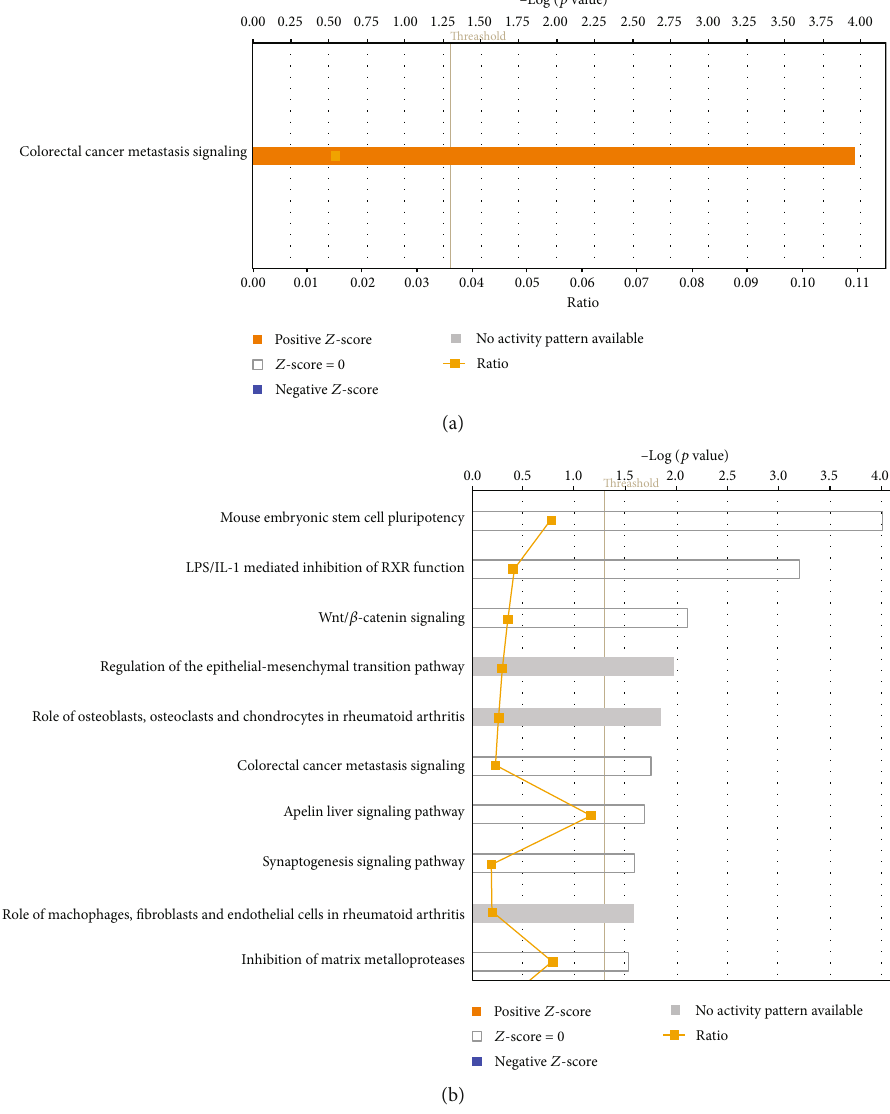
Figure 2: (a) Low-intensity ultrasound (LIUS) upregulates 21 out of 1376 (1.5%) innatomic genes and downregulates 17 out of 1376 (1.2%) innatomic genes in mouse preosteoblast cells (GSE45487), suggesting that LIUS increases innatomic gene expressions slightly more than decreasing them in mouse preosteoblast cells (see supplemental Table 2 for the detailed gene list). LIUS upregulated 21 innatomic genes that were signi fi cantly involved in one signaling pathway in mouse preosteoblasts, which is in fl ammation-driven cancer metastasis signaling. (b) LIUS downregulated 17 innatomic genes that were not signi fi cantly involved in any signaling pathway in mouse preosteoblast cells, suggesting that LIUS inhibits innatome in preosteoblasts in multipathways in a nonsigni fi cant